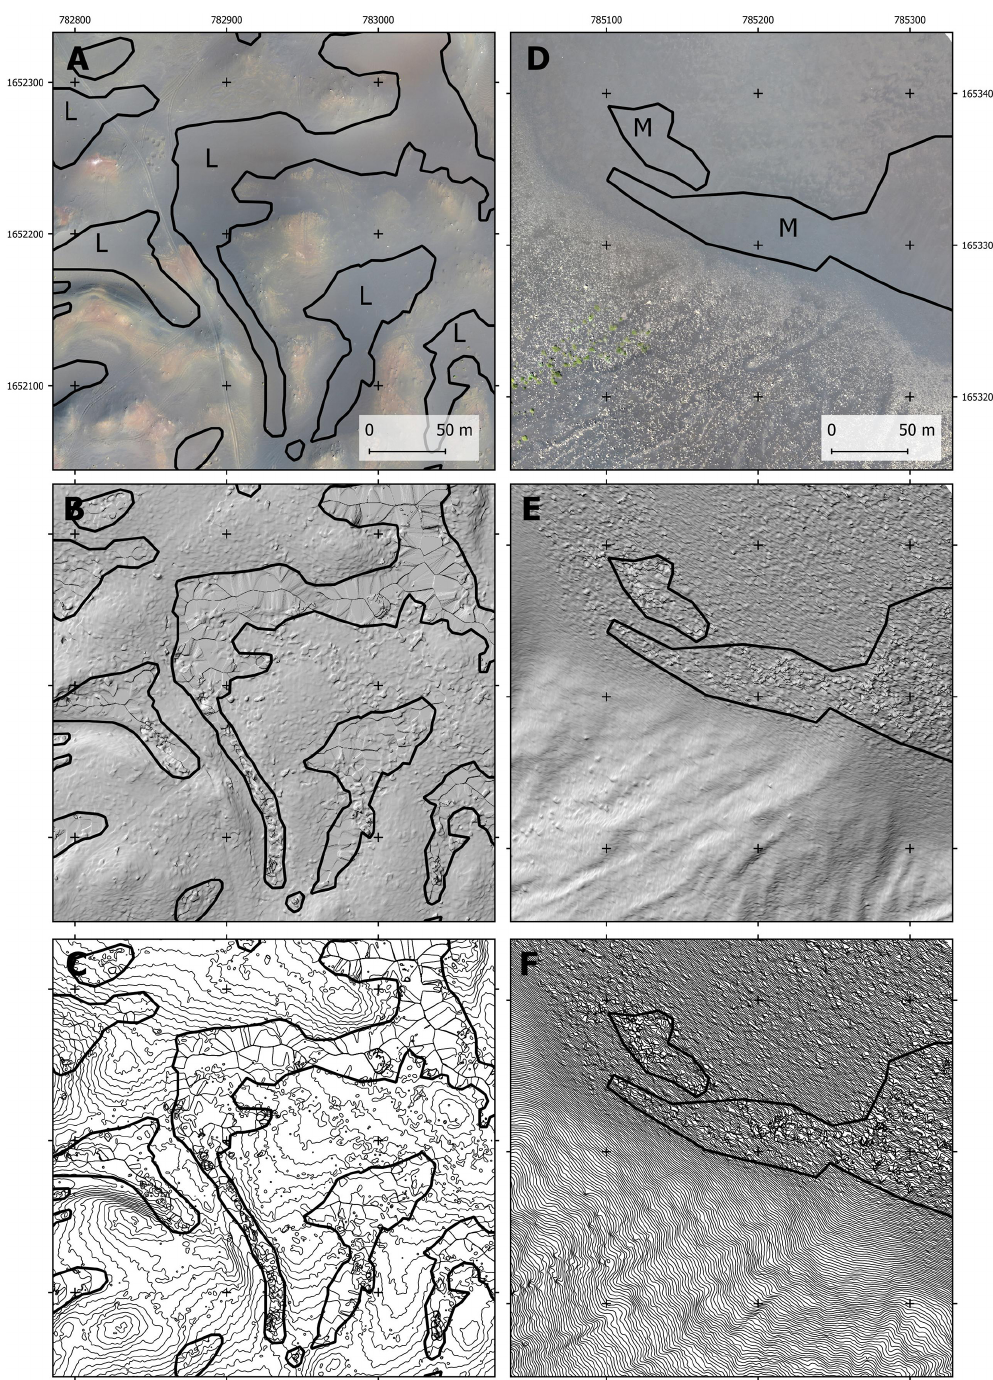
Figure 7. Examples of surfaces with high, medium and low quality in the DSM. (a–c) Steep slope covered with ash with medium-quality results (M) for the digital surface model ( a – orthomosaic, 10cm; b – hill shade model, 10cm; c – contour lines, 50cm). The contours are very irregular in detail, but the overall slope at a coarse resolution is maintained. The area where the deposits are coarser (outside the polygon) provides a good DSM. (d–f) Irregular surfaces with linear depressions covered with ash with low-quality results (L), with orthomosaic for visualization ( a – orthomosaic, 10cm; b – hill shade model, 10cm; c – contour lines, 50cm). The contours are very irregular and show numerous errors. The border with the good- quality areas is sharp with good topography where the ground surface is coarser. The location of the figures is shown in Fig.